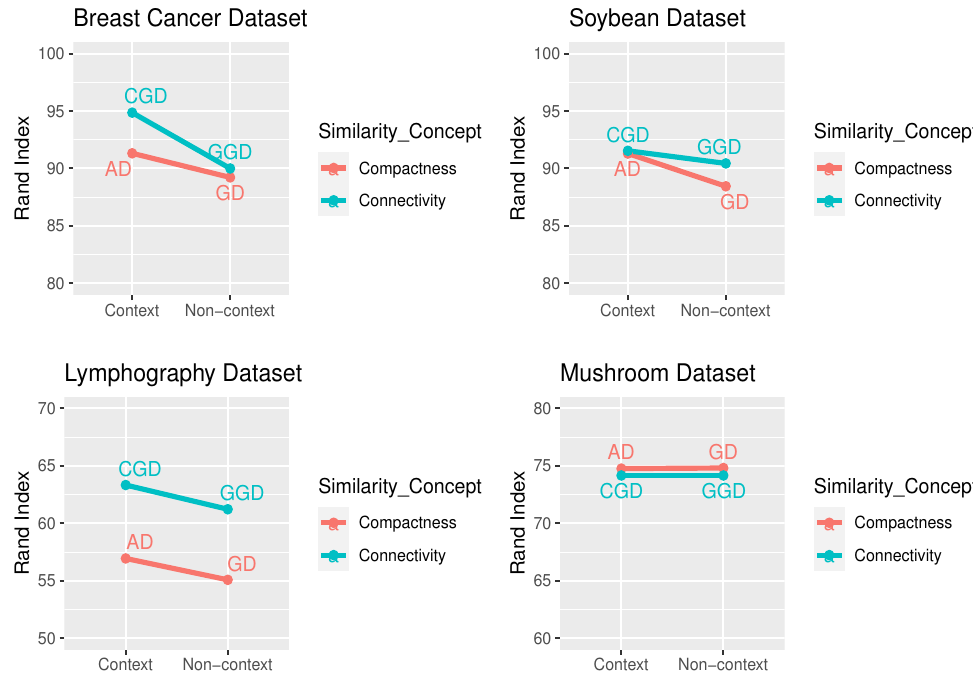
Figure 4. Rand index on four real-life datasets; Gower distance (GD), association-based dissimilarity (AD), Gower-based geodesic distance (GGD), and content-based geodesic dissimilarity